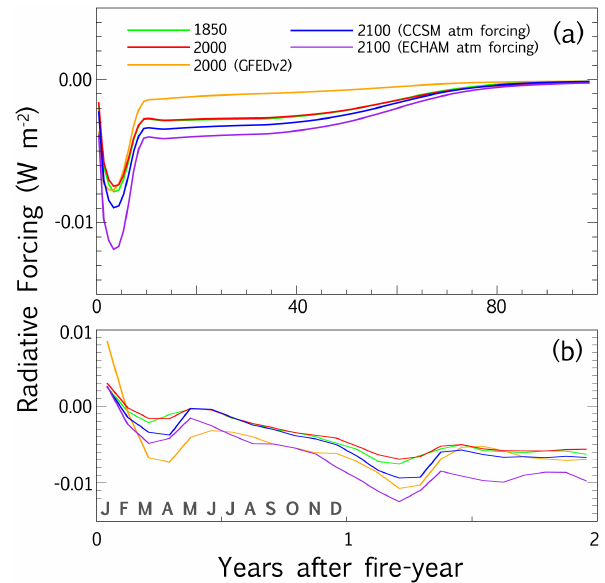
Fig. 9. A plot of the radiative forcing (RF) due to land surface albedo changes caused by fires and how it changes during the years following the fire disturbance in a) annual averages beginning the year after a full year of fire activity, and b) monthly averages following one full year of fire activity. Each colour represents different fire emissions from CLM3 or from GFEDv2 as indicated by the legend.